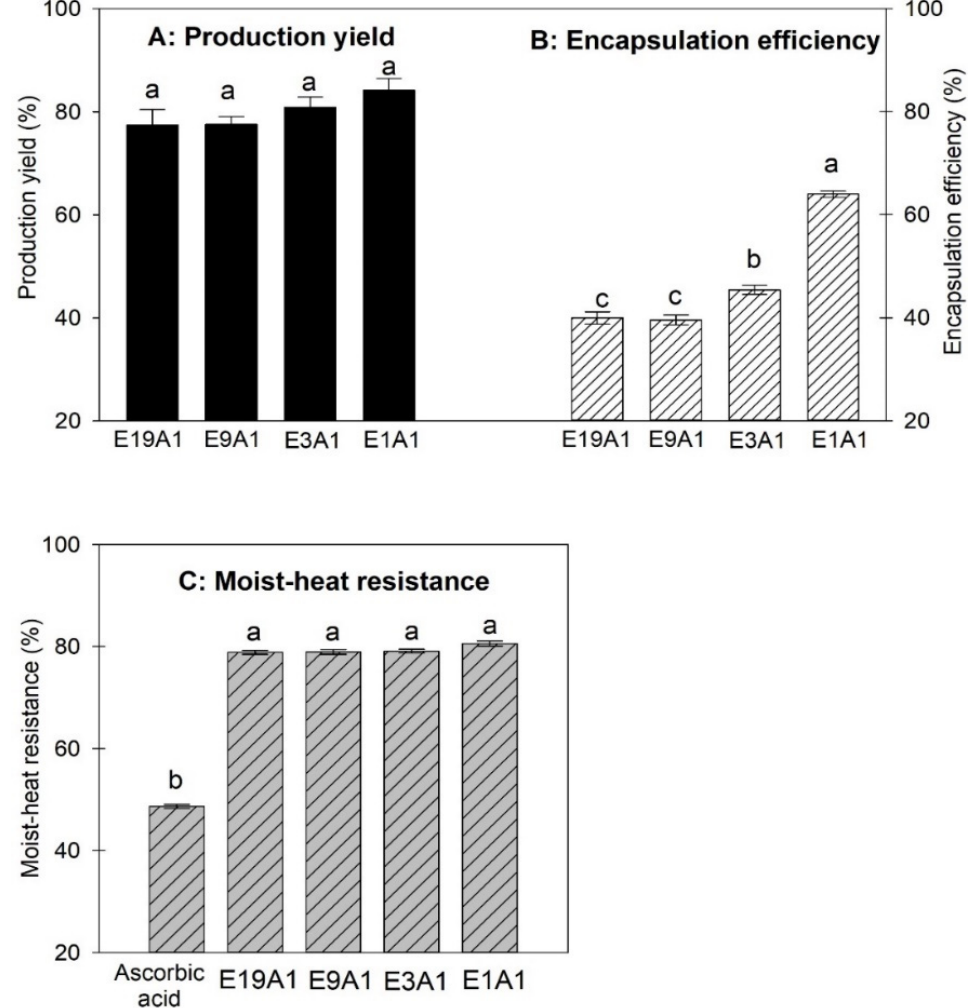
Figure 1. ( A ) Production yield of microcapsules prepared from different EY-AA mass ratio; E19A1, E9A1, E3A1 and E1A1. ( B ) Encapsulation efficiency of microcapsules prepared from different EY/AA mass ratio; E19A1, E9A1, E3A1 and E1A1. ( C ) Moist heat resistance of unencapsulated AA and microencapsulated AA E19A1, E9A1, E3A1 and E1A1.The different superscripts in each figure indicate significant differences of the values ( p < 0.05).